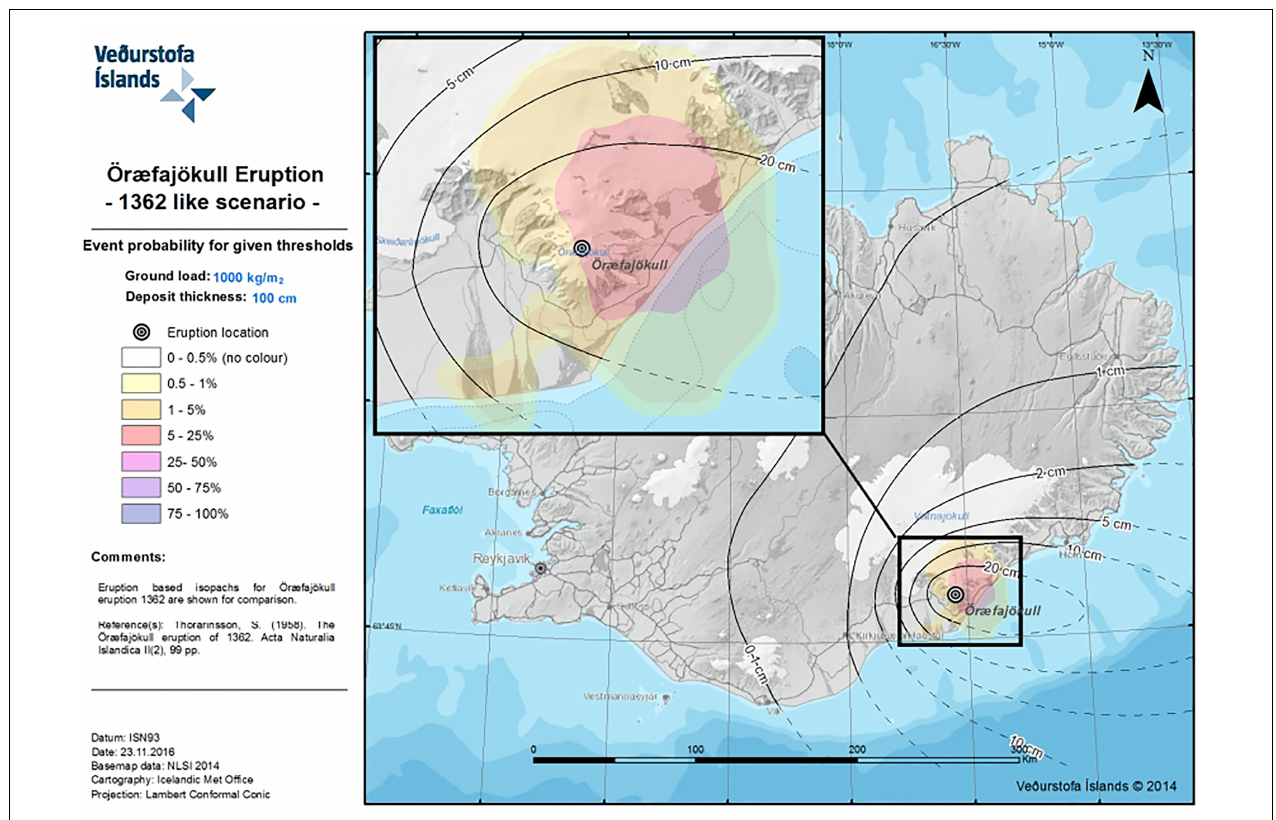
FIGURE 8 | Probabilistic hazard map for tephra loading higher than 1000 kg/m 2 given an eruption at Öræfajökull as 1362 AD. The isopachs reconstructed by Thorarinsson (1958) are reported as a reference with black lines.